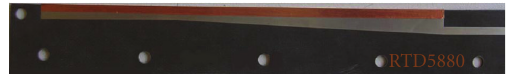
Figure 5: A prototype of half curve tapered leaky-wave antenna..